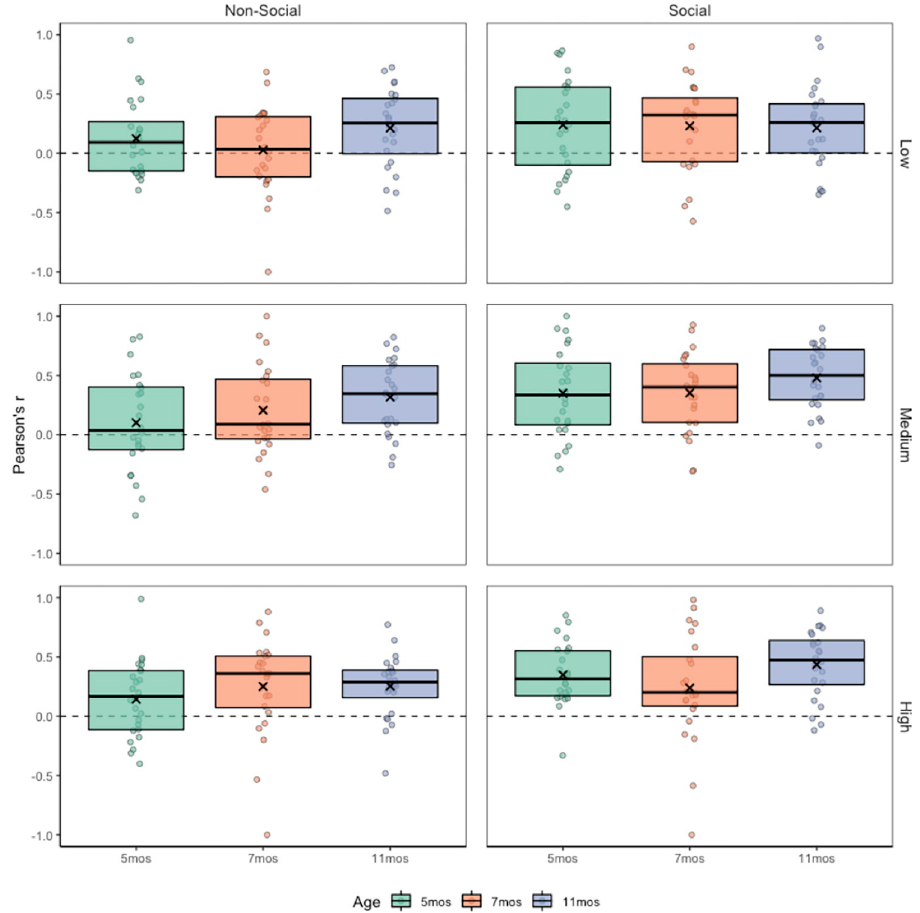
Fig 6. Correlation between fixations and subsequent contiguous saccade amplitudes. Positive correlations reflect high scanning efficiency. Boxplot edges represent upper and lower quartiles, center line represents the median, and ‘X’ represents the mean. Individual dots represent subject-level Pearson correlation coefficients (r). Average number of observations per r as follows: 5 months = 20.28 (SD = 6.18), 7 months = 17.91 (SD = 7.30) and 11 months = 17.69 (SD = 5.08). Asterisks denote significant difference from zero as follows: � p < .05, �� p < .01, ��� p < .001.